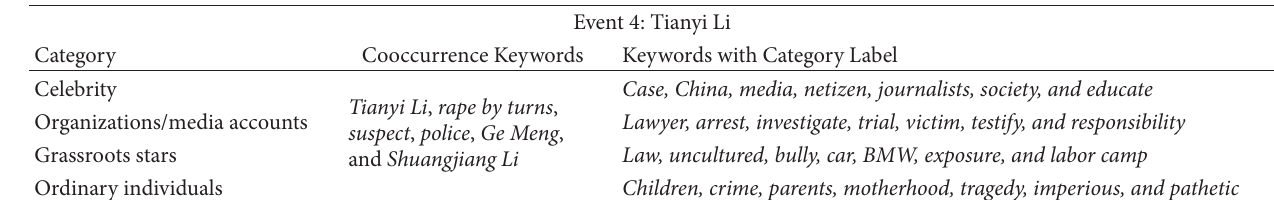
Table 8: Keywords distribution on the event of “Tianyi Li.” Event 4: Tianyi